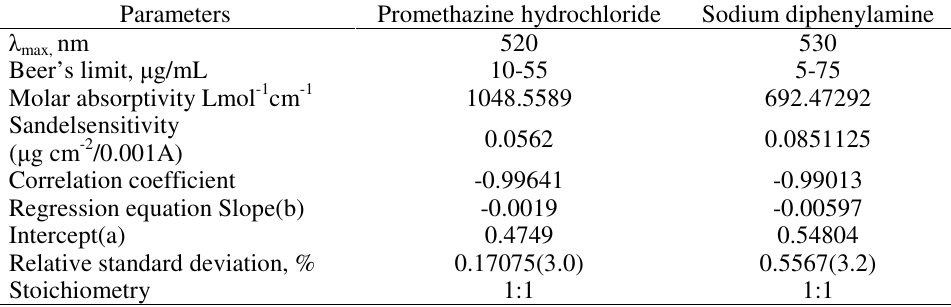
Table 4. Optical characteristics of the proposed